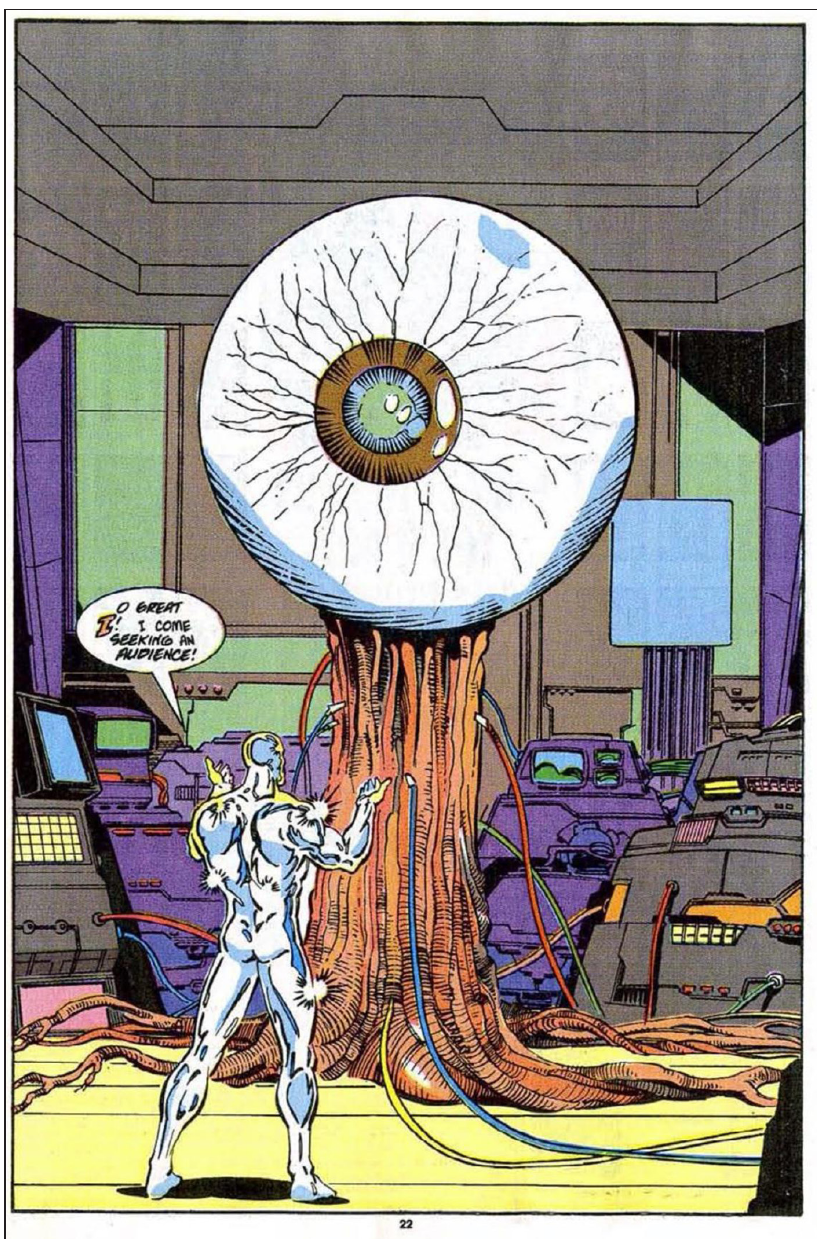
Figure 5: The Silver Surfer #42. New York: Marvel, 1990, p. 22. Jim Starlin & Ron Marz (writers), Ron Lim (penciler), Tom Christopher & Christopher Ivy (inkers), Ken Bruzenak (letterer), Tom Vincent (colorist), Craig Anderson (editor), Tom Defalco (Chief). © 1990 Marvel Entertainment Group,